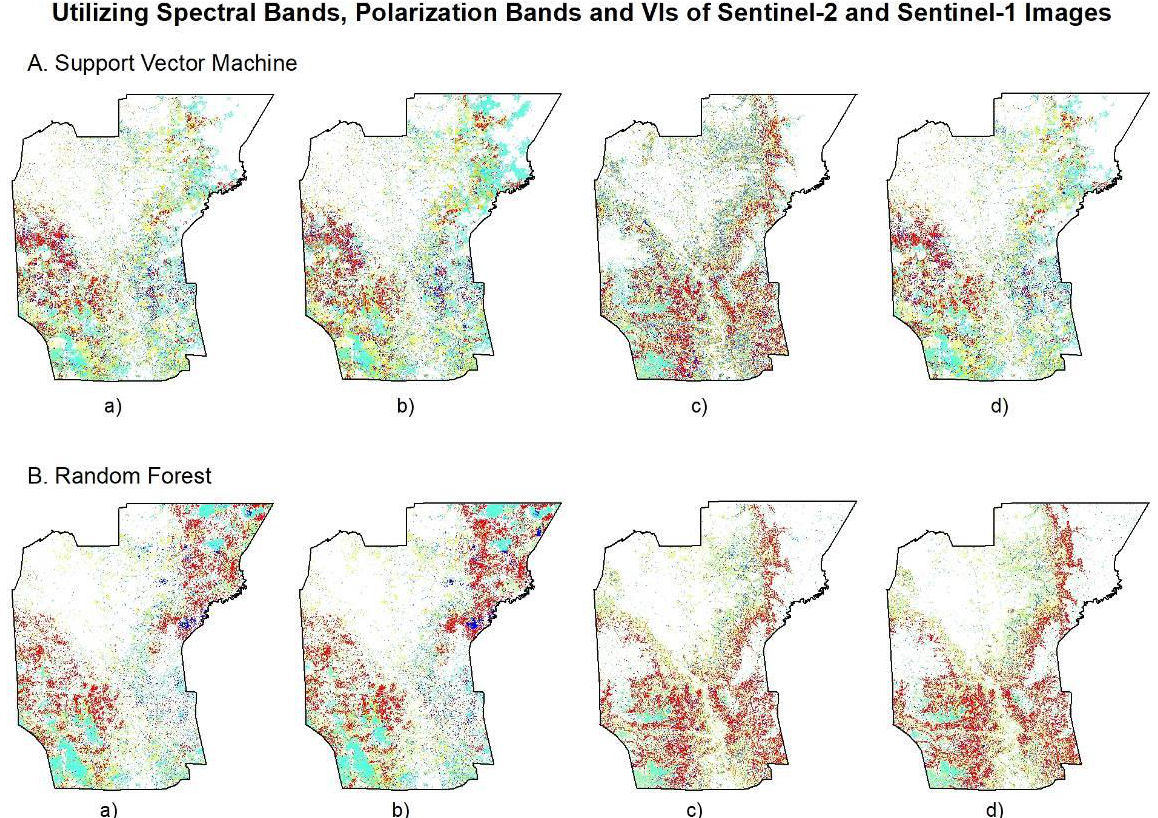
Figure 5. Classification results for Falcata stand ages using: a) Multitemporal Sentinel-1 and Sentinel-2 data with VIs, b) Multitemporal Sentinel-2 data with VIs c) Single Year Sentinel-1 and Sentinel-2 data with VIs, d) Single Year Sentinel-2 data with